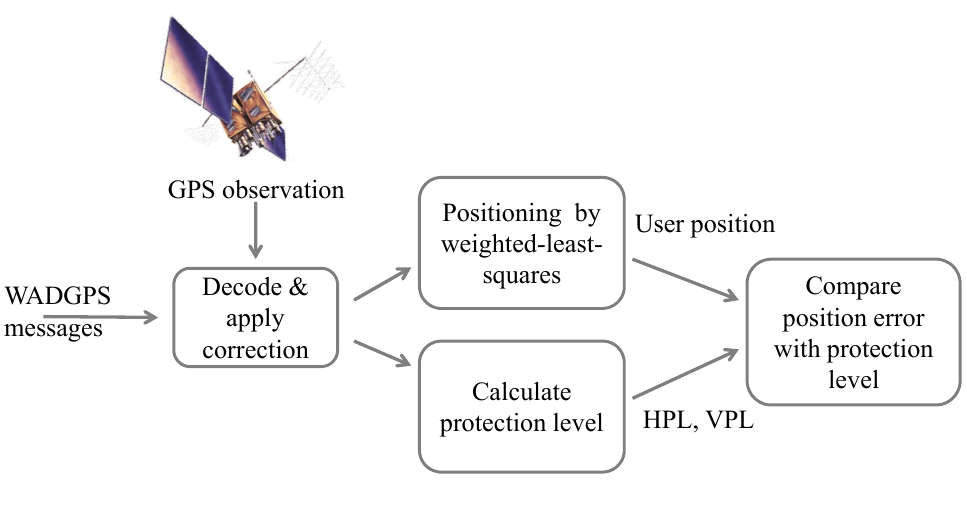
Figure 10. The procedures of the WADGPS user